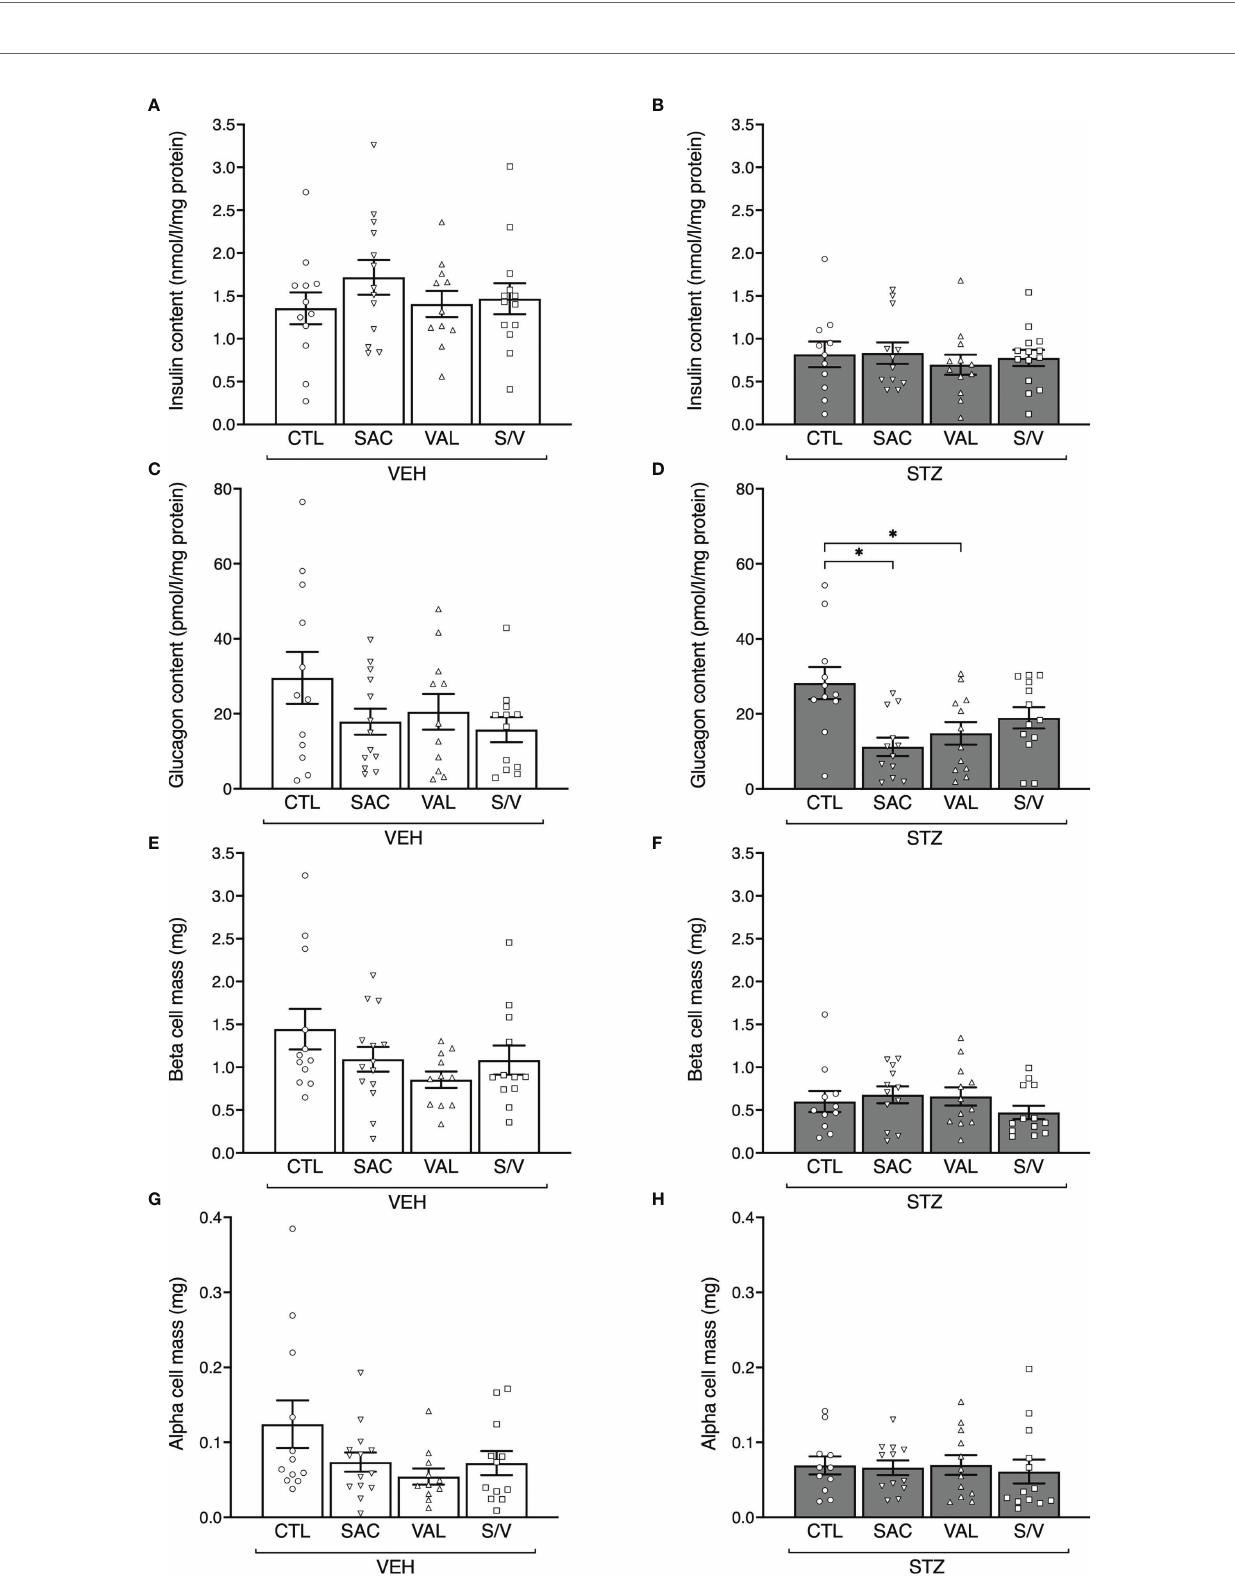
FIGURE 4 | Sacubitril, valsartan and sacubitril/valsartan do not affect beta- and alpha-cell mass. Insulin content (A, B) , glucagon content (C, D) , beta-cell mass (E, F) and alpha-cell mass (G, H) at the end of the 8-week treatment period in vehicle ( A, C, E, G ; VEH) and streptozotocin ( B, D, F, H; STZ) injected high fat-fed mice treated with control (CTL), sacubitril (SAC), valsartan (VAL) or sacubitril/valsartan (S/V). n=11-14/group.